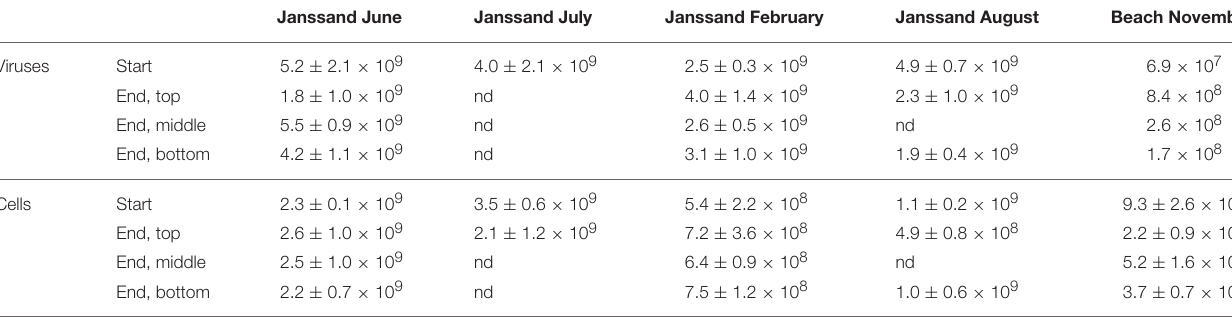
TABLE 1 | Virus and cell numbers (cm − 3 ) in the sediments at the start and end of the